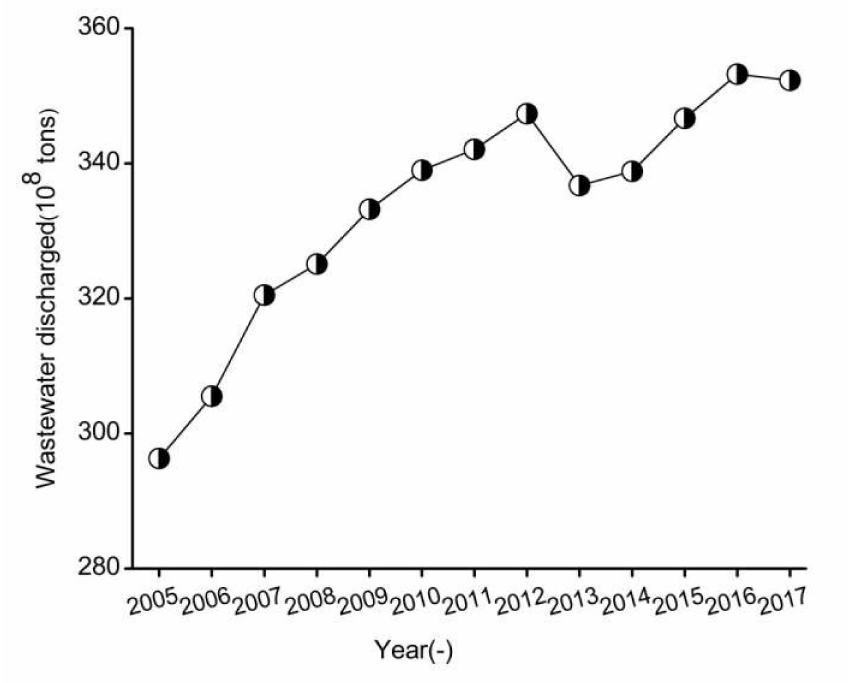
Figure 10. Wastewater discharge in the Yangtze River Basin between 2005 and